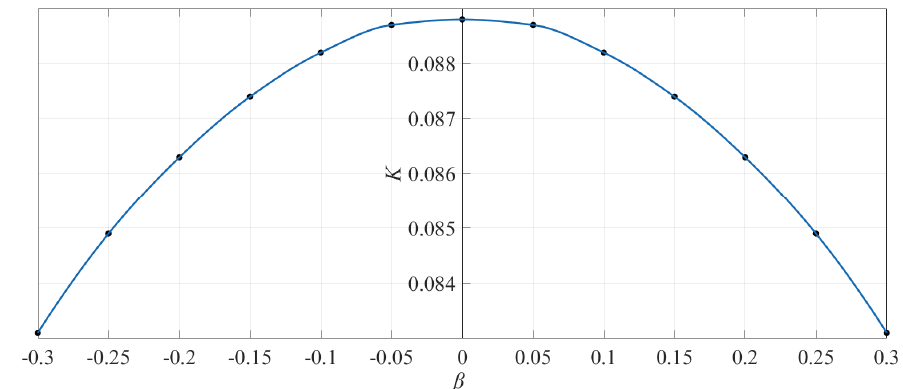
Figure 11. Variation of bending stiffness K with β ( λ h = 1.0 and λ t = 0.03).